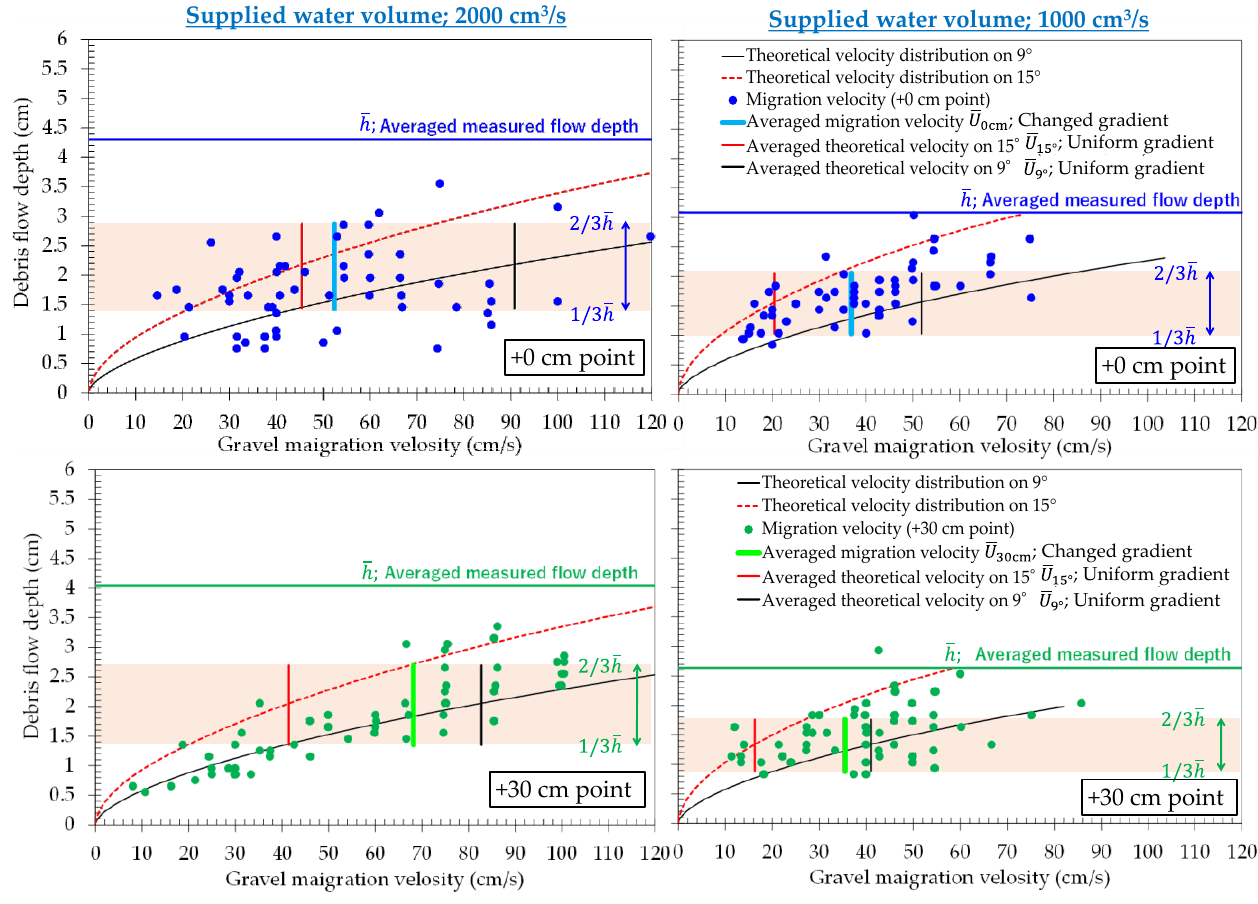
Figure 6. Measured gravel velocity distributions in the interior of the “frontal part” of the debris flow in the cases involving a changing gradient and theoretical velocity distributions on uniform gradients of 9°and 15° for Case 3.